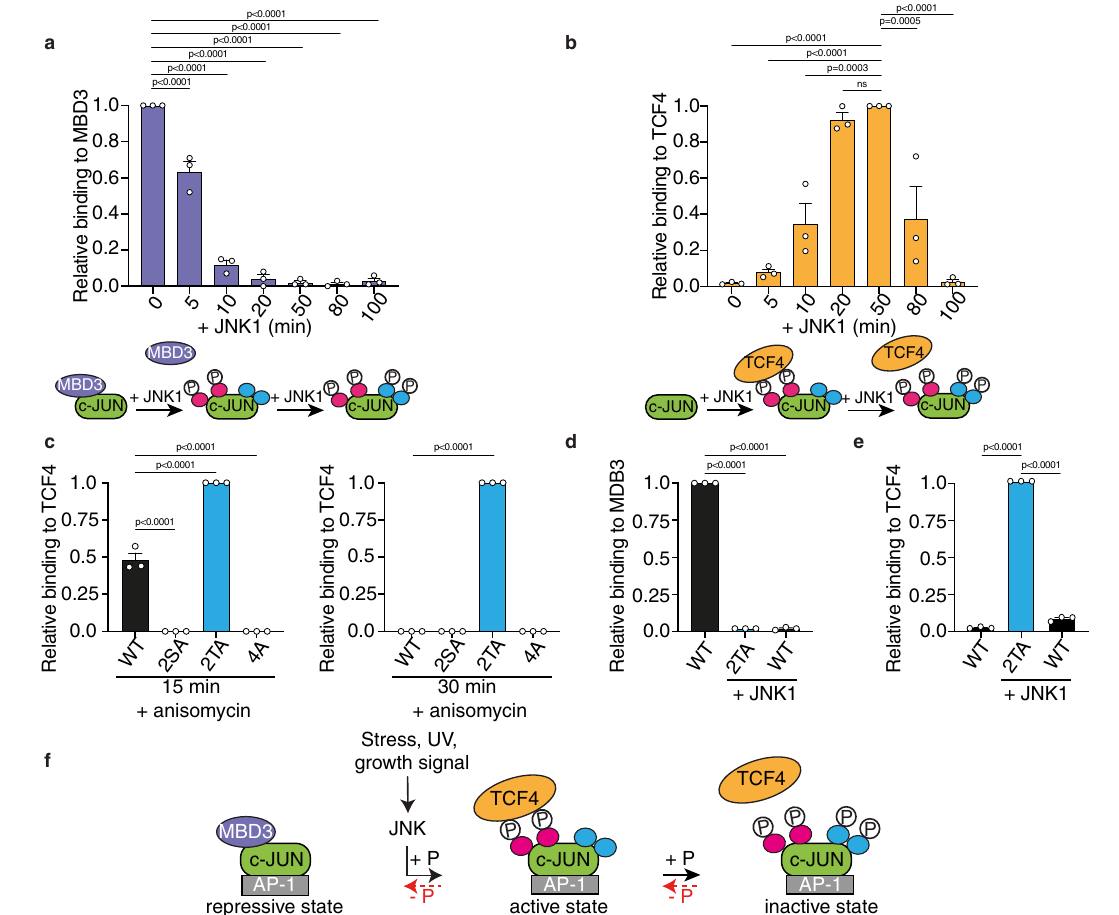
Fig. 6 | Effect of c-JUN temporal phosphorylation events on protein partners binding. a , b HCT116 cell extracts were used in pull-down assays, using GST-c-JUN TAD as bait, phosphorylated by JNK1 at the indicated times. Recovered proteins were analysed by immunoblotting for MBD3 ( a ) or TCF4 ( b ). Quanti fi cation of the detectedproteinlevelswasperformedusingtheImageStudioLiteSoftware(Licor), andnormalizedtotheboundGST-c-JUNTADandrelativetothe0min( a )or50min ( b ) prey binding (top). Schematic representation of the recovery of MBD3 ( a ) and TCF4 ( b ) from the performed pull-downs (bottom). c The indicated fl ag-tagged c- JUNwild-typeorderivatives,transientlyoverexpressedinHCT116cells,treatedwith either JNKi or anisomycin for the indicated time, were immunoprecipitated using Flag antibody. Immunoprecipitates were analysed for interaction with TCF4 and the quanti fi cation of the detected TCF4 protein levels that were immunoprecipi- tated wasperformed using the Image Studio Lite Software (Licor), and normalized